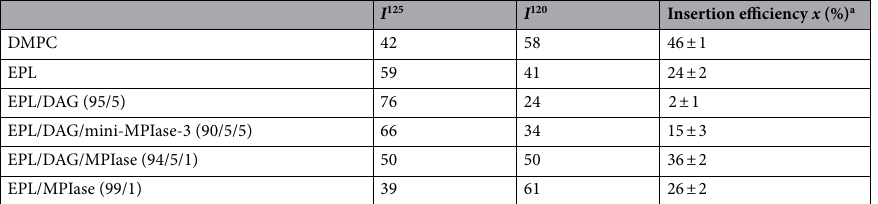
Table 2. Relative signal intensities at 125 ppm ( I 125 ) and 120 ppm ( I 120 ) shown in Fig. 3d–i, and the insertion efficiency of Pf3_24, x , into the various membranes. a x values were calculated using Eq. (1). Errors were estimated from the noise in each spectrum in Fig. 3d–i using the method described in Supplementary